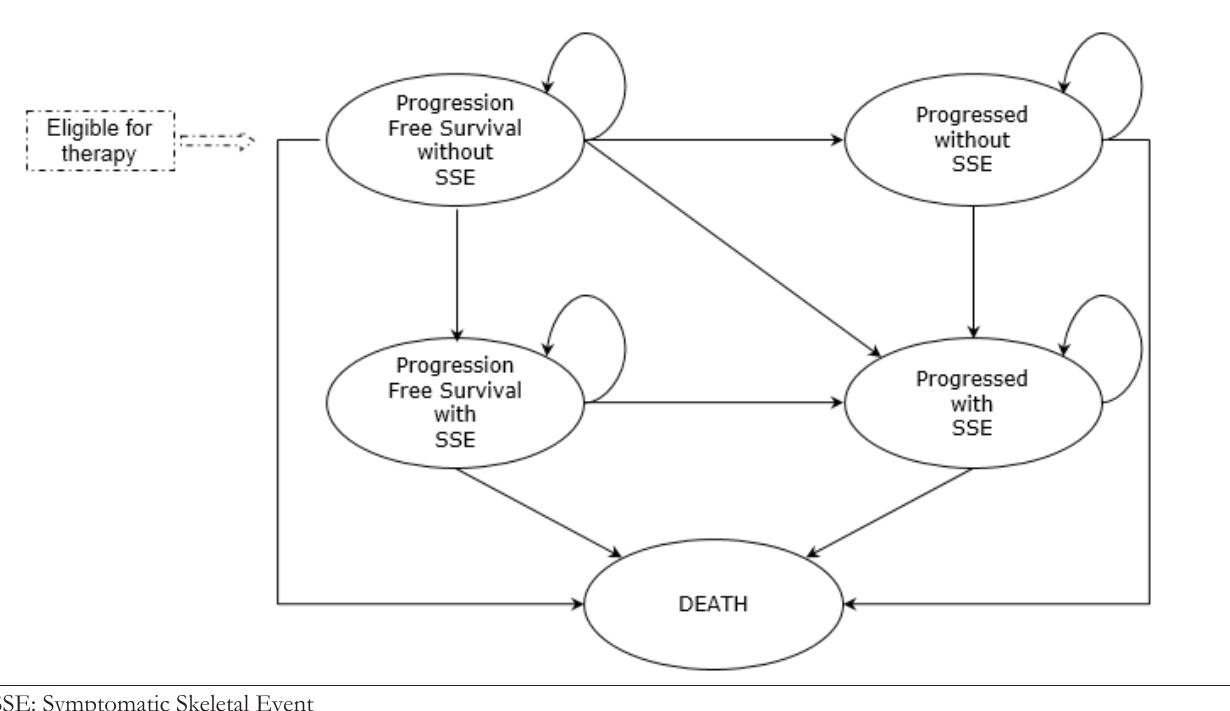
Figure 1. Markov Model for mCRPC